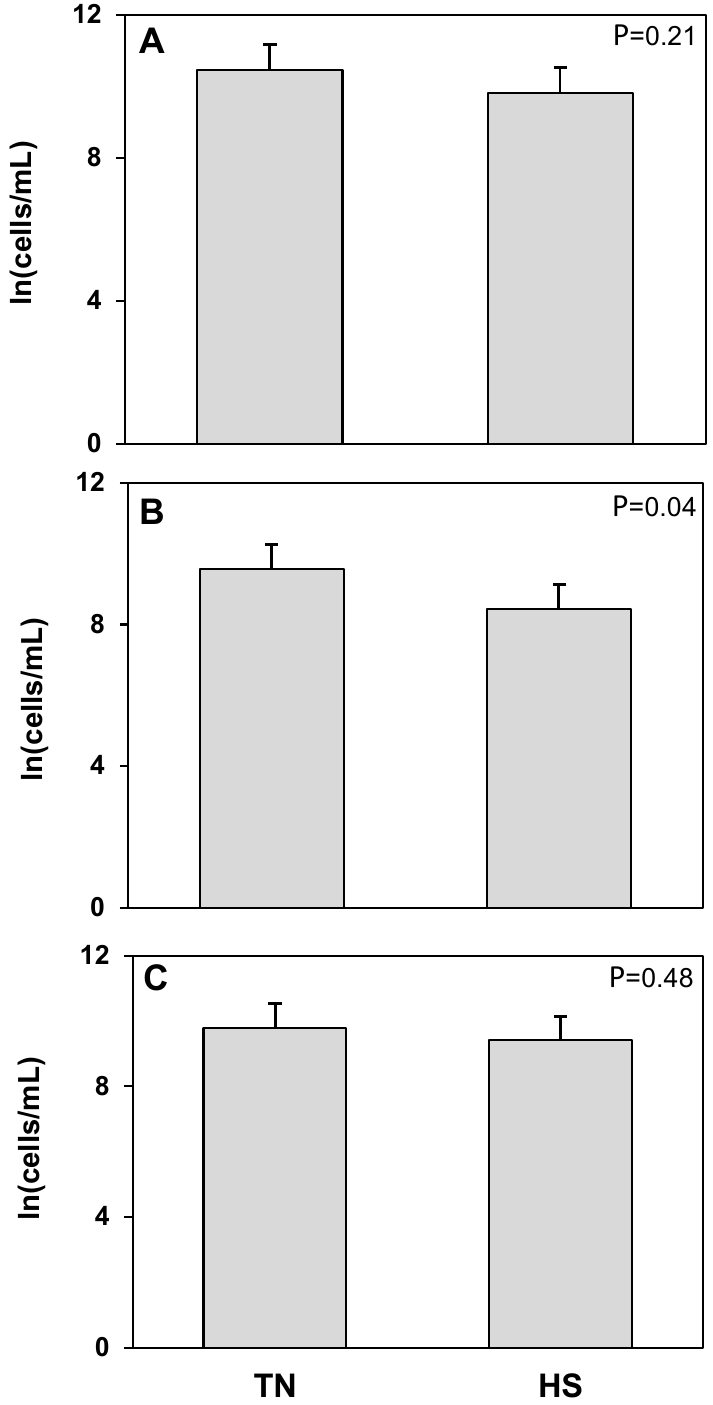
Figure 2. Heat stress (HS) impacts on hematopoietic (CD45 + BTN − ) cell concentration in milk com- pared to thermoneutral (TN) conditions. ( A ) Total cells, ( B ) live cells (propidium iodide negative; PI − ), and ( C ) dead cells (propidium iodide positive; PI + ). Cell population data were natural log trans- formed for statistical analysis. Values presented are least square means of natural log transformed data with error bars presenting the SEM (n = 10).